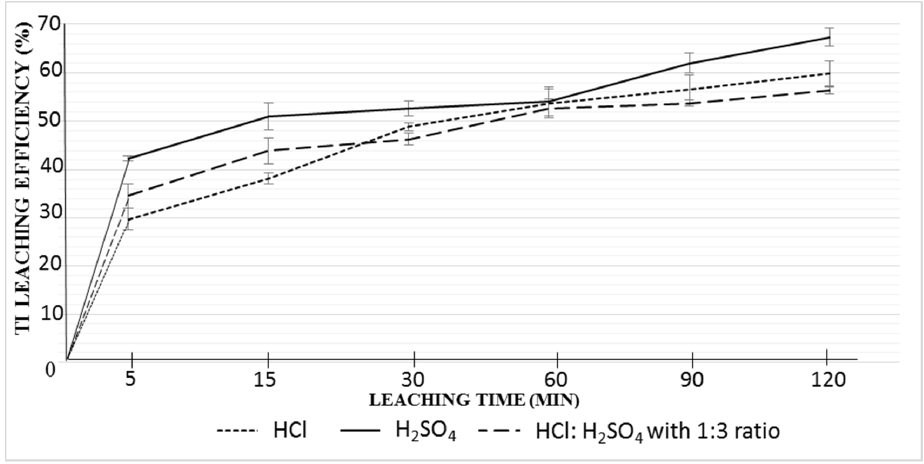
Figure 1. Leaching efficiencies of Ti with various acids (where 100% Ti efficiency corresponds to 0.94 g Ti in 1 L acid solution).